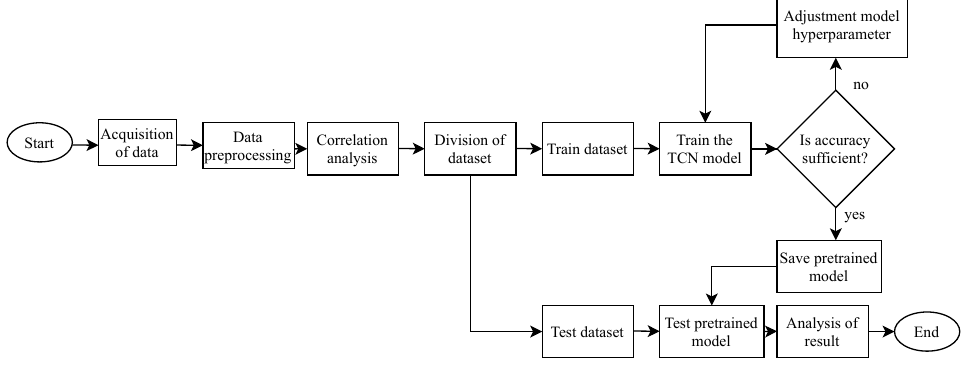
Figure 3. Flowchart of water quality prediction model.